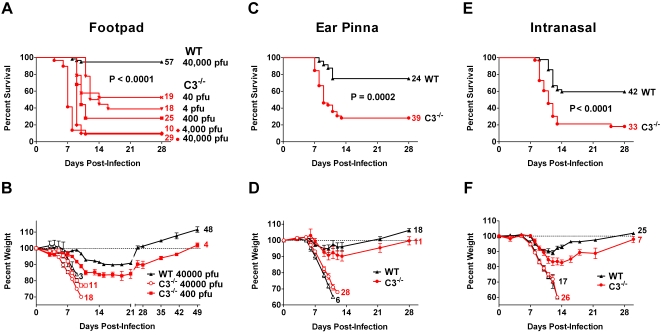
C3 deficiency increased mortality and morbidity in C57BL/6 mice.(A,C,E) Greater mortality was observed in C3−/− compared to wild-type (WT) C57BL/6 mice by multiple routes of inoculation. The number of animals in each group is right of the line, and the statistics compare the survival of C3−/− and wild-type mice. (B,D,F) C3−/− mice have increased morbidity following infection by the indicated route as monitored by weight loss. Weight loss for individual animals was normalized to their starting weight, and mean±SEM is shown. The graph segregates the mice that survived the infection (filled symbols) from those that succumbed (open symbols). The number of animals in each group is presented at the end of the line. (A,B) Mice were inoculated in the footpad with the dose listed to the right of the survival curve or in the legend. The survival curves were generated from two to three separate experiments (except for a single experiment at 4,000 pfu). The survival of the C3−/− mice significantly differed from the wild-type mice at all doses (P<0.0001). (B) The one C3−/− mouse that survived at 40,000 pfu is not shown for clarity. C3−/− mice alive at day 49 continued to gain weight until day 119 post-infection. (C,D) Mice were inoculated with ∼700 pfu ECTV via the ear pinna. The data are combined from four separate experiments (P = 0.0002). (E,F) Mice received 100 pfu of ECTV intranasally. The curves are generated from at least seven separate experiments (P<0.0001).